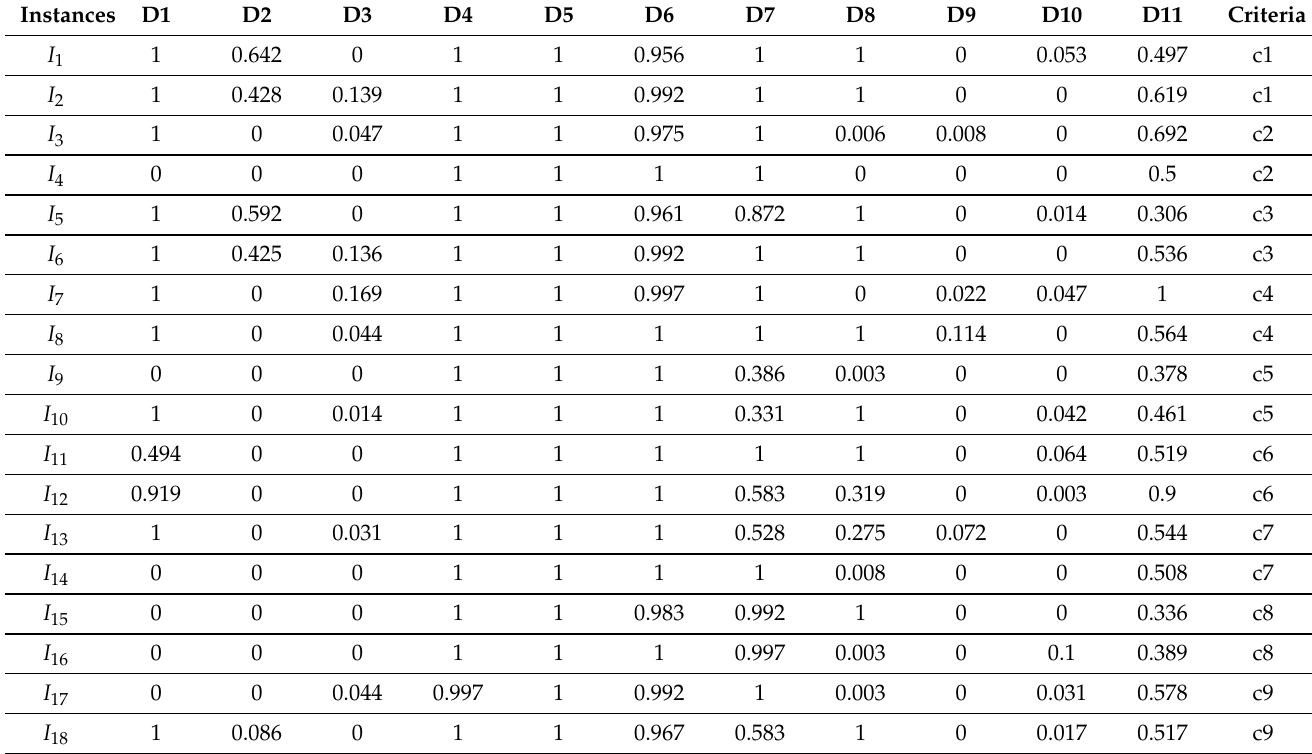
Table 2. Data Instances and Different aspects of ED